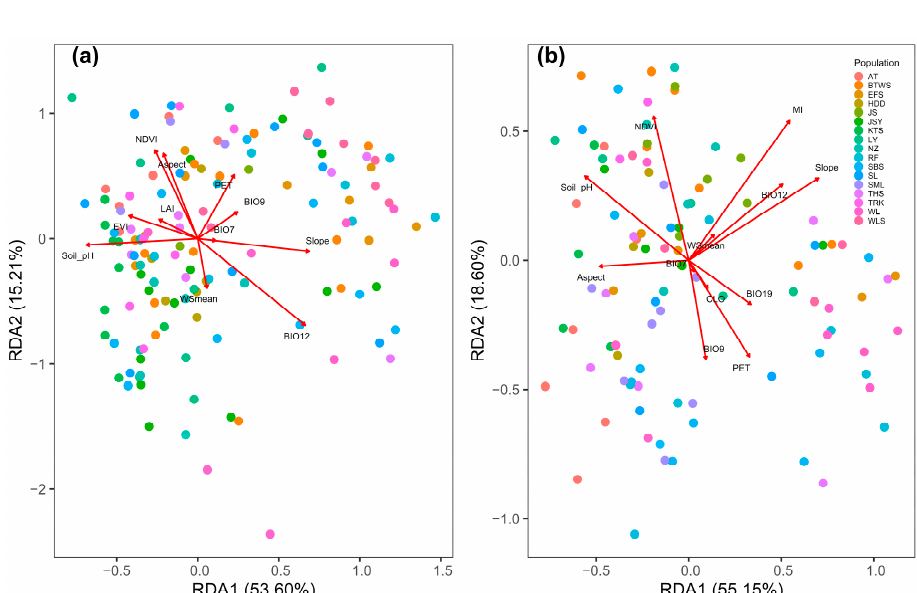
Figure 4. Partial RDA analysis using ( a ) mMSAP and ( b ) uMSAP variation explained by the effects of the environment conditioned on the geographic effect. The colored points refer to individuals (colors represent which population they were sampled from), and the red vectors represent environmental predictors. The length and direction of vectors indicate relative correlation strength of the environmental predictors with RDA axes.